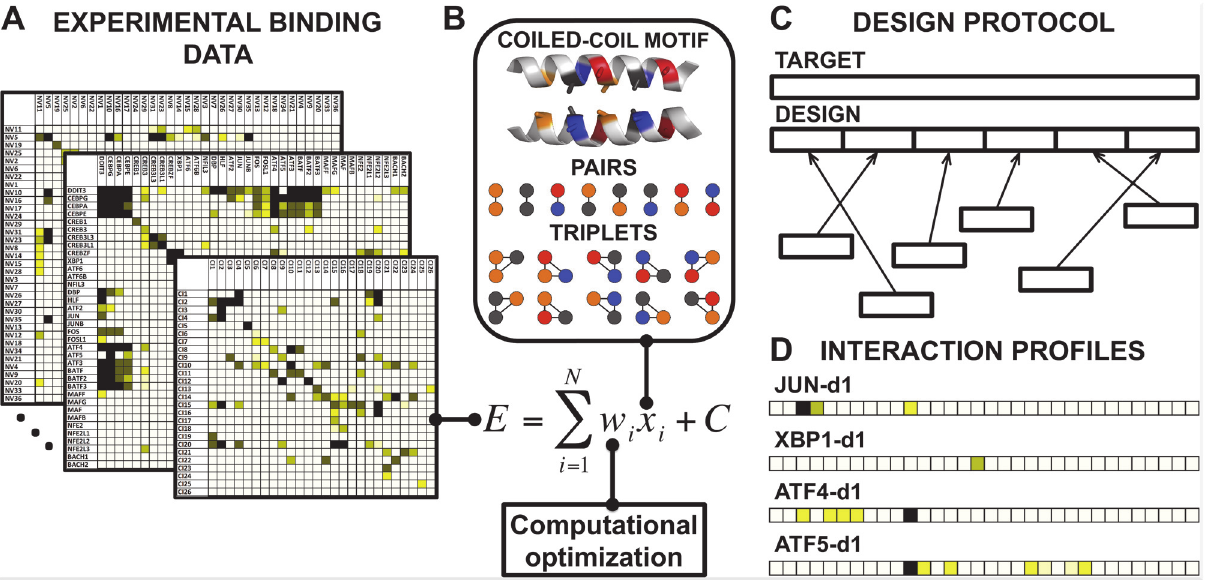
Fig 1. Schematic representation of the model-building and design protocol used to generate selective bZIP-interacting peptides. (A) Experimentally determined dissociation constants for 4,549 bZIP interaction pairs were used as input to train a scoring model. (B) Weights corresponding to contributions from pairs and triplets of residues were fit to experimental binding data using a regression technique. The appropriate optimized weights can be summed to provide a predicted binding energy for two aligned bZIP coiled-coil sequences. (C) Binders were designed by using coiled-coil heptads as building blocks. Optimal combinations of heptads to construct tight-binding and selective designs were identified using integer linear programming in conjunction with the developed scoring function. (D) Designed sequences exhibit tight and selective binding to target bZIP coiled coils. Each square in the cartoon corresponds to a native human bZIP coiled coil, and cells are colored by the strength of interaction of each bZIP with the indicated designed peptide; darker shades correspond to stronger binding. Names of the bZIP proteins corresponding to each cell are given in S5 Table.